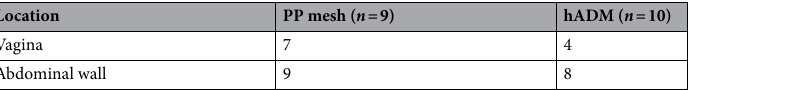
Table 4. Description of the analyzed explants during the mechanical test. n = number of analyzed samples.